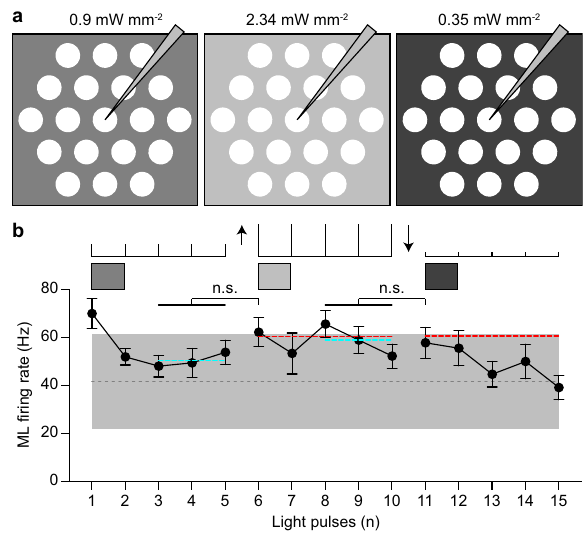
Fig. 9 Modulation of stimulus contrast without spatial content. a Sketch of the stimulus contrast modulation paradigm. Pixels were repeatedly illuminated with large- fi eld illumination at 5 Hz (560 nm, 10 ms) for 3 s, and the irradiance level was changed every fi ve pulses (0.9, 2.34 and 0.35 mW mm − 2 ). The fi rst change was a step increase while the second change was a step decrease. b Quanti fi cation of the ML fi ring rate (mean ± s.e.m.) under modulation of the stimulus contrast without spatial content ( n = 12 RGCs). The cyan dashed lines are the average desensitised ML fi ring rates and the red dashed lines are the recovery thresholds. The grey dashed line is the average resting fi ring rate with its s.d. represented by the grey